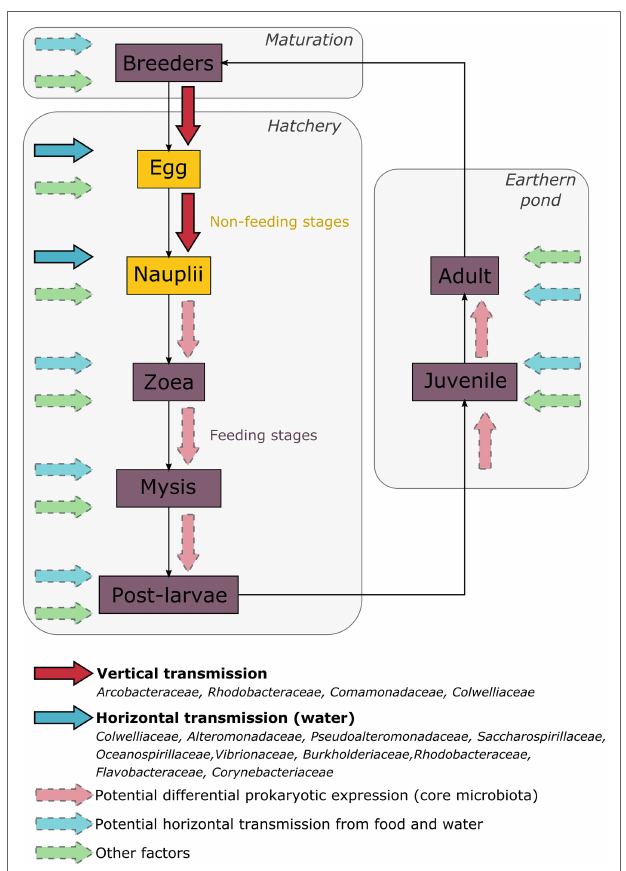
FIGURE 7 | Schematic representation of the factors influencing the microbiota of the Pacific blue shrimp at all developmental stages. The egg, nauplii, zoea, and mysis stages belong to the larval